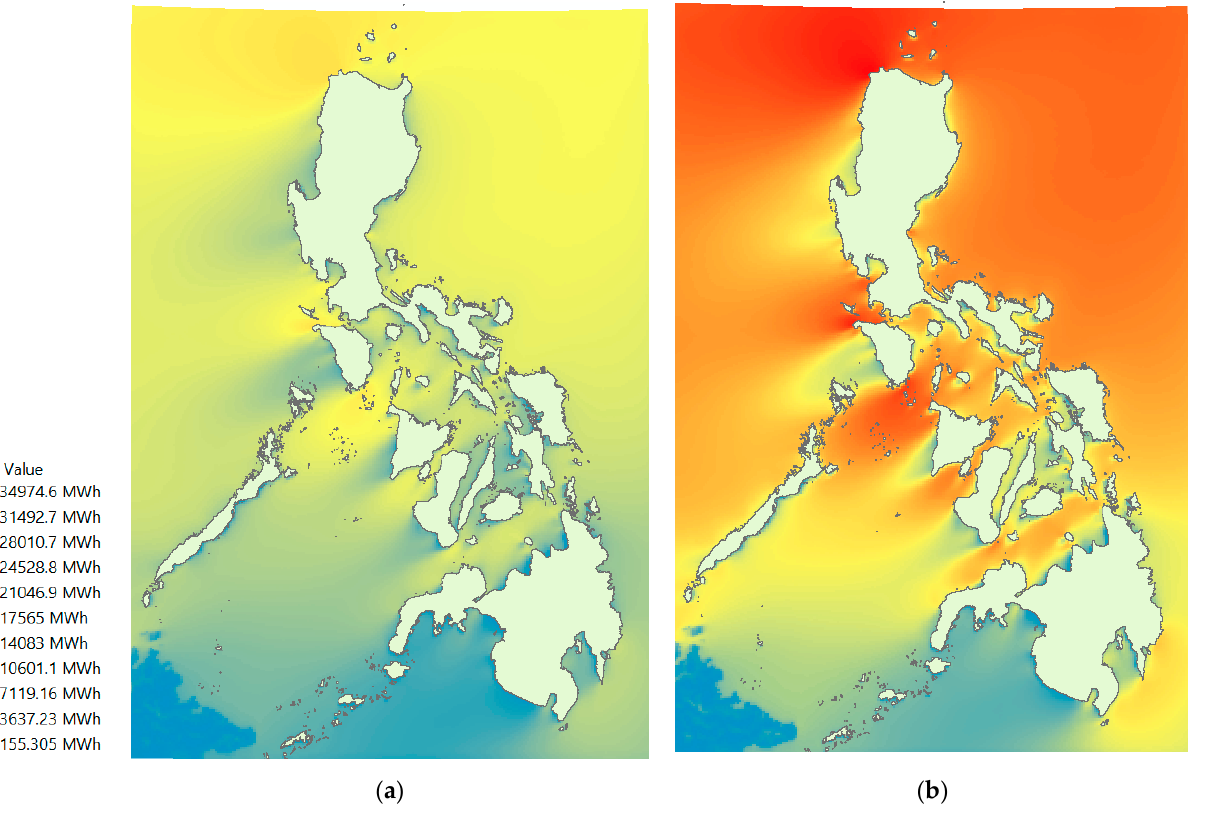
Figure 19. Annual energy production of ( a ) SWT-3.6-120 and ( b ) 6.2M126.